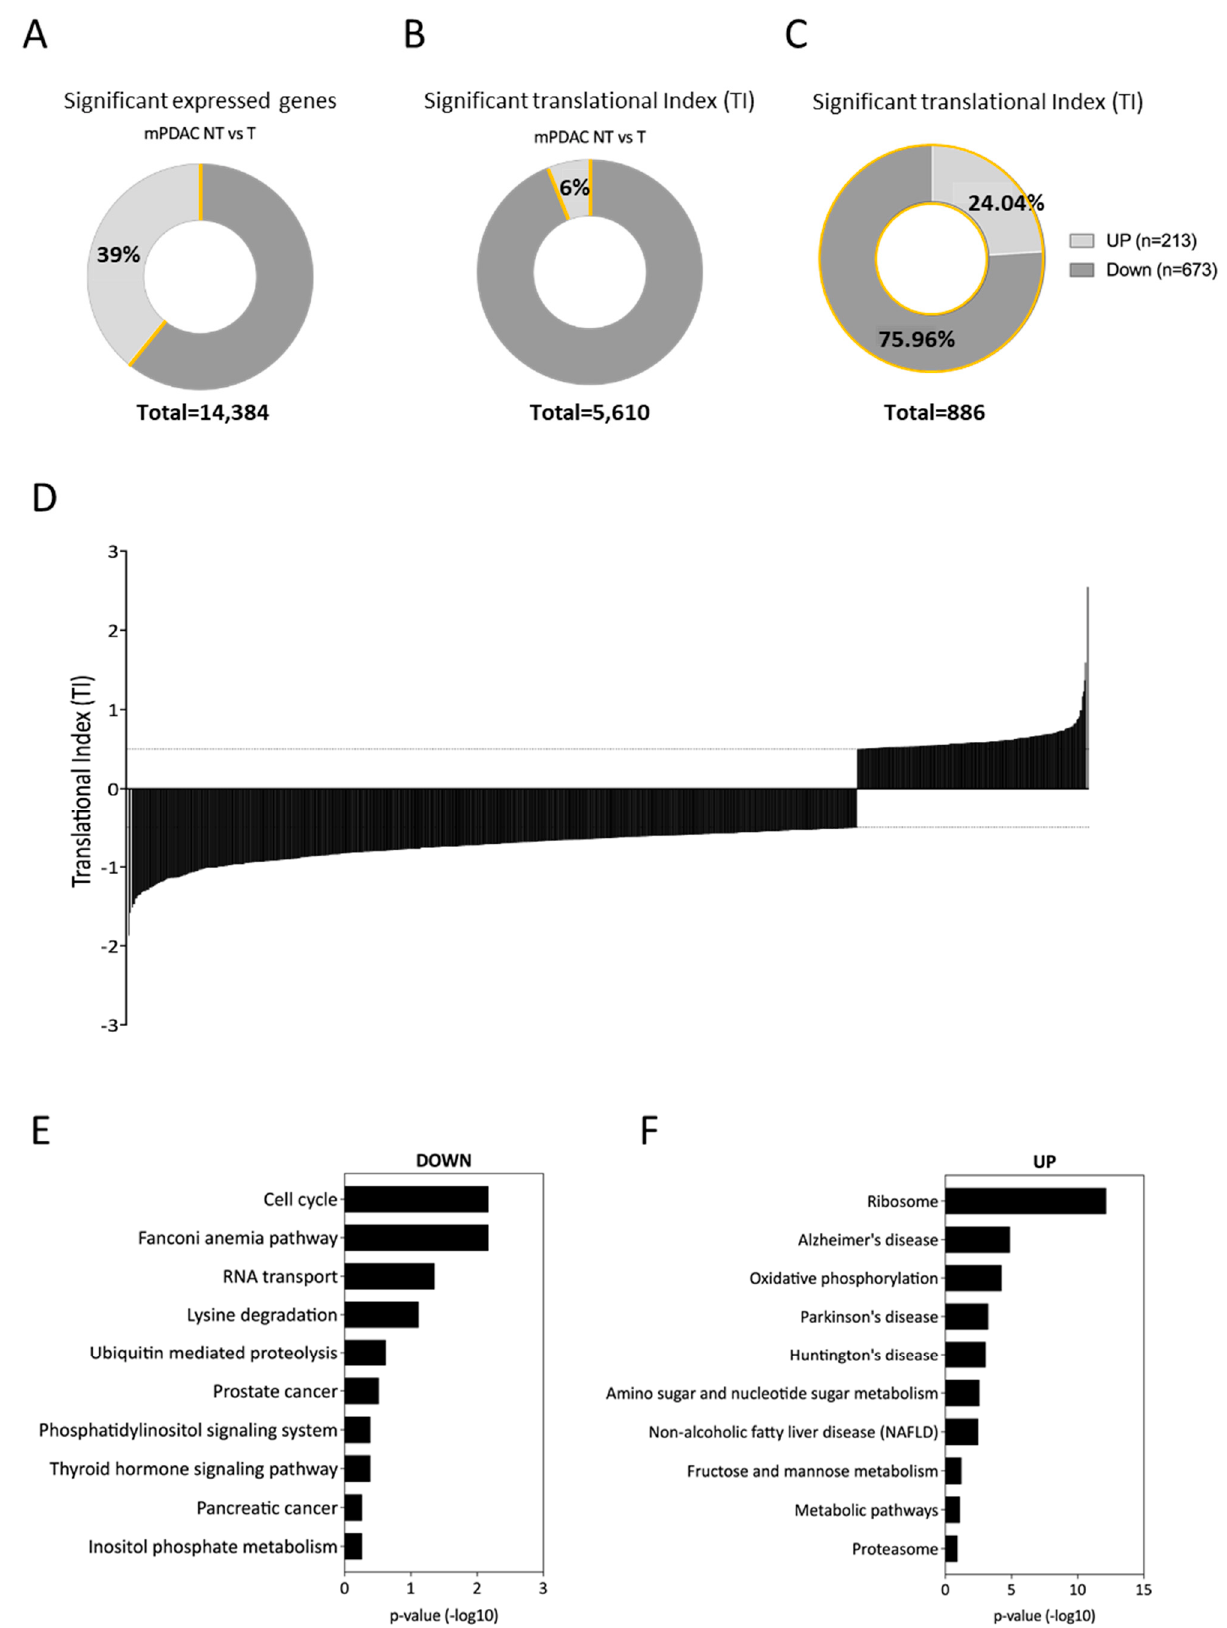
Figure 2. Bioinformatics analysis of mPDAC cell translatome upon N6L treatment. A —Percentage of translationally deregulated mRNAs in response to N6L treatment. Among the 14,384 blasted genes, 39% (5,610) were significantly expressed